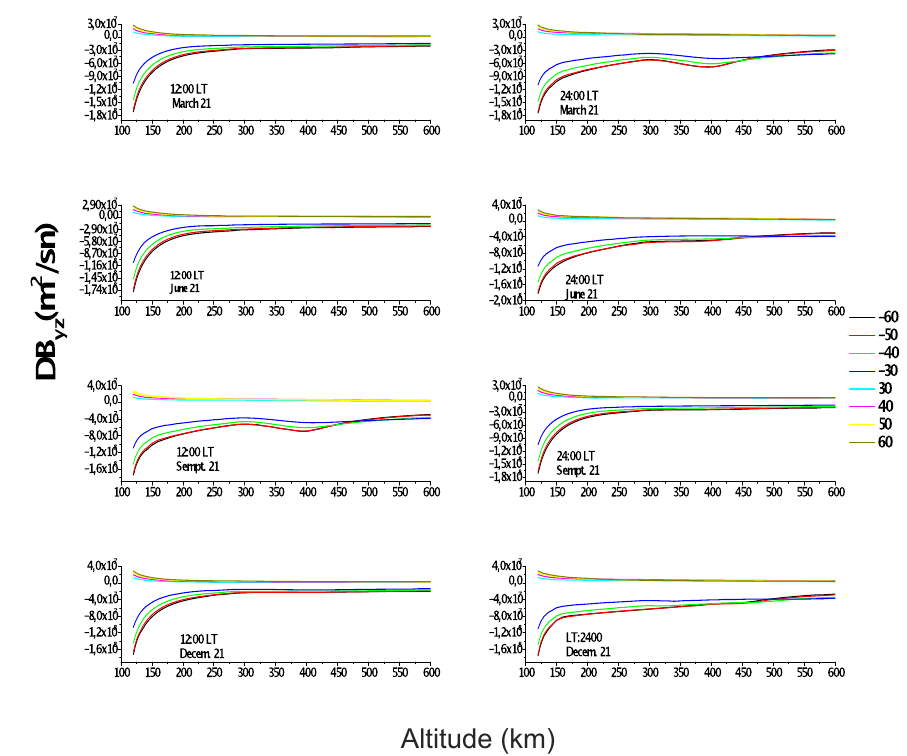
(m 2 /sn) in Equation (10) for mid-latitude in ionospheric plasma. xy